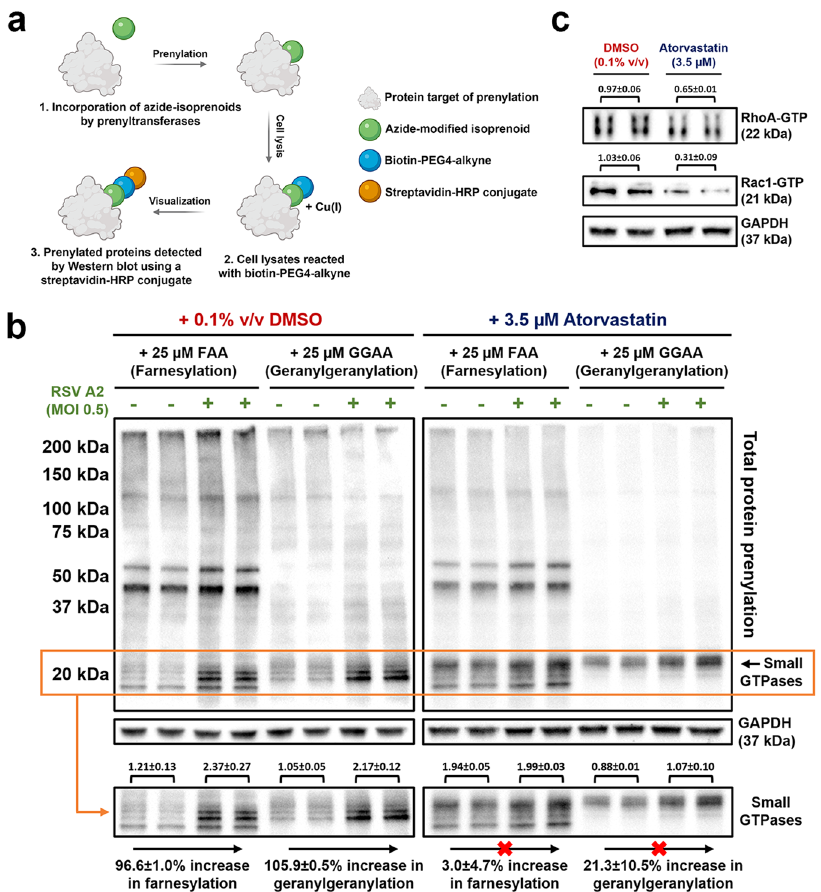
Fig. 6 Statins mitigate RSV-induced increases to Rho GTPase prenylation and activity. a A click chemistry-based approach was used to isolate and visualize prenylated proteins. HEp-2 cells were treated with azide-modi fi ed isoprenoids, farnesyl alcohol azide (FAA) or geranylgeranyl alcohol azide (GGAA), and infected with RSV A2 (MOI 0.5). Lysates were collected 48 h p.i. and conjugated to biotin-PEG4-alkyne by a copper-catalyzed reaction. Prenylated proteins were then visualized by western blot using a streptavidin-HRP probe. b RSV A2 infection of HEp-2 cells (MOI 0.5) induced an increase in total protein prenylation (farnesylation and geranylgeranylation) relative to uninfected cells 48 h p.i. Notably, the virus increased the prenylation of ~20 kDa proteins corresponding to small GTPases (as outlined on the blot). Atorvastatin (3.5 µ M) treatment 2 h post-viral exposure inhibited the RSV- induced increase to small GTPase prenylation (both farnesylation and geranylgeranylation). c The subcellular localization and activity of Rho GTPases is regulated by prenylation. Active, GTP-bound RhoA and Rac1 levels were measured 48 h p.i. by af fi nity puri fi cation of RSV A2-infected HEp-2 lysates (MOI 0.5) + / − atorvastatin (3.5 µ M). Atorvastatin reduced the GTP-bound levels of both RhoA and Rac1 in infected cells. Averaged GAPDH-normalized band intensity is denoted by the numbers above each lane. Values are reported as means ± SEM ( n = 2 cell lysates). GAPDH controls were processed on a parallel blot with the same samples and protein